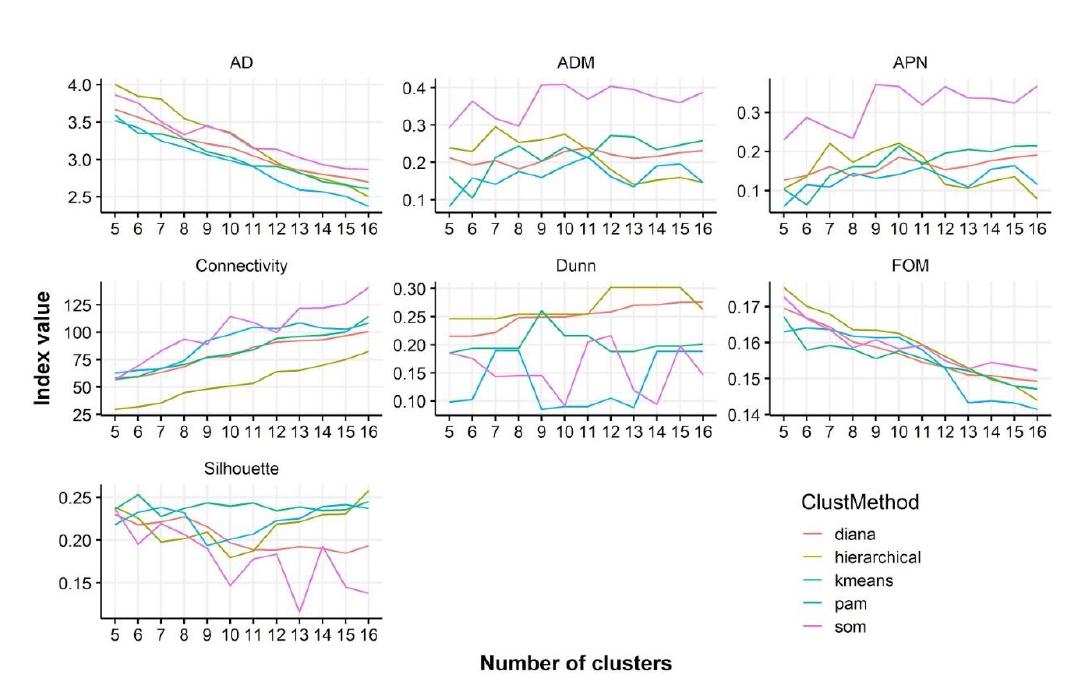
Figure A1.4. Comparison of clustering methods for reference. Performance